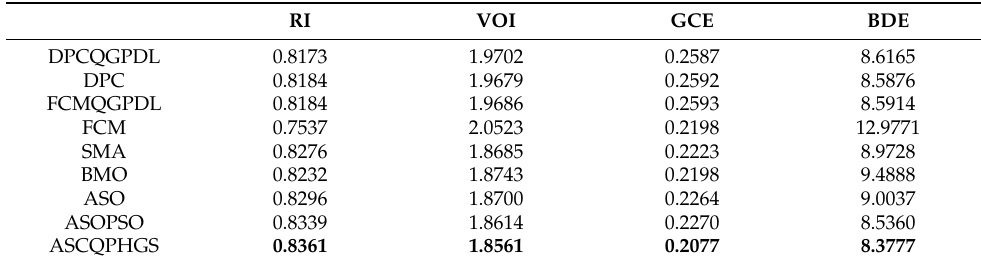
Table 1. Results of competitive techniques for the BSDS500.